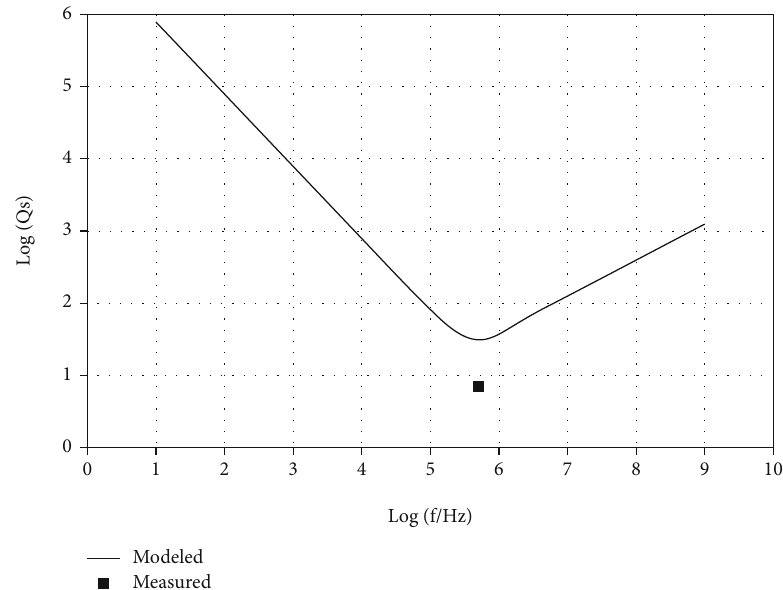
’ Euville limestone under